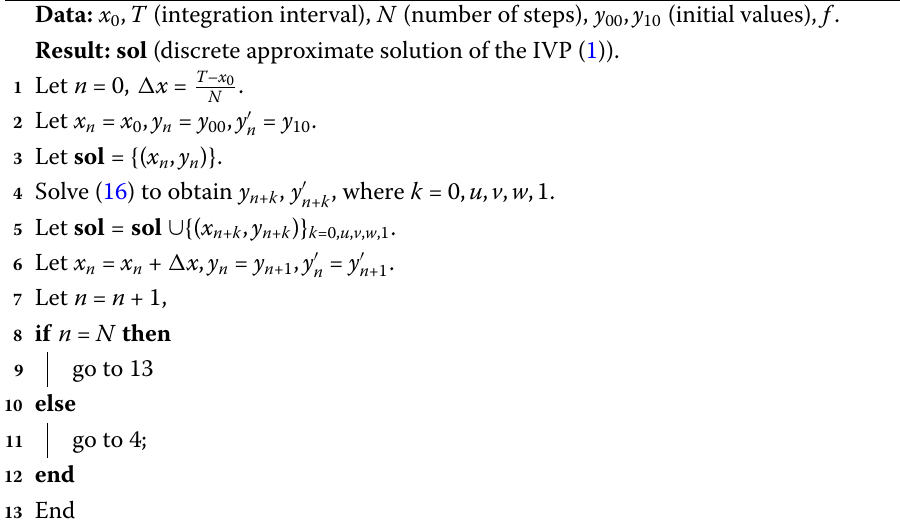
Algorithm 1: Pseudocode for the optimal one-step A -stable block